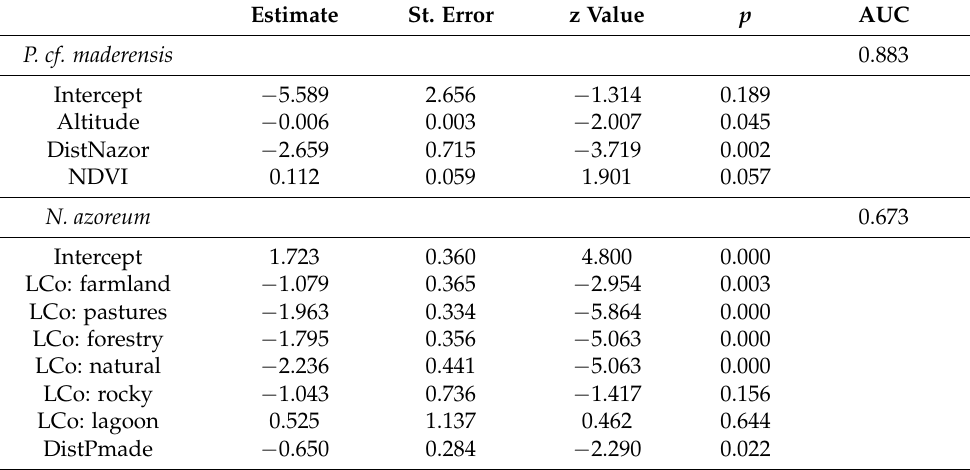
Table 2. Parameters for the best candidate models for the distribution data of P. cf. maderensis (top) and N. azoreum (bottom) based on an information-theoretic approach using the Akaike information criterion for small samples (AICc). All variables are described in Table A1. The land-cover (LCo) descriptor uses urban areas as the indicator class. The area under the ROC curve (AUC) is presented as a measure of adjustment of each